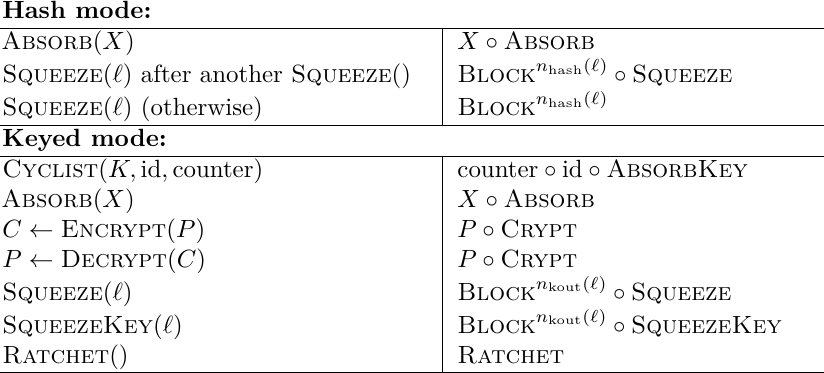
Table 1: Symbols and strings appended to the process